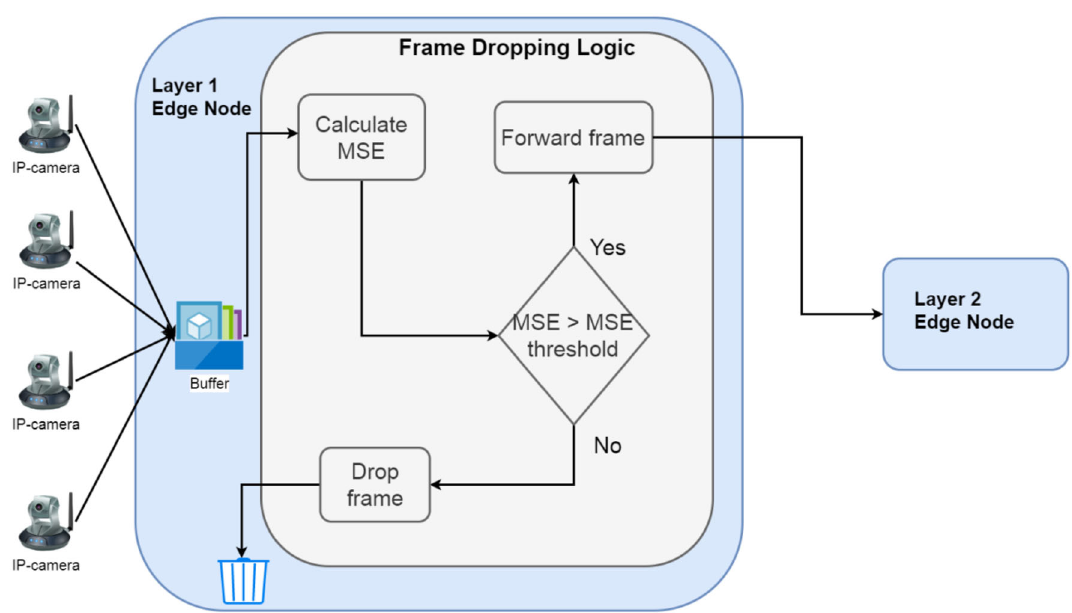
Fig. 2 Campus-wide video analytics framework (CVAF)